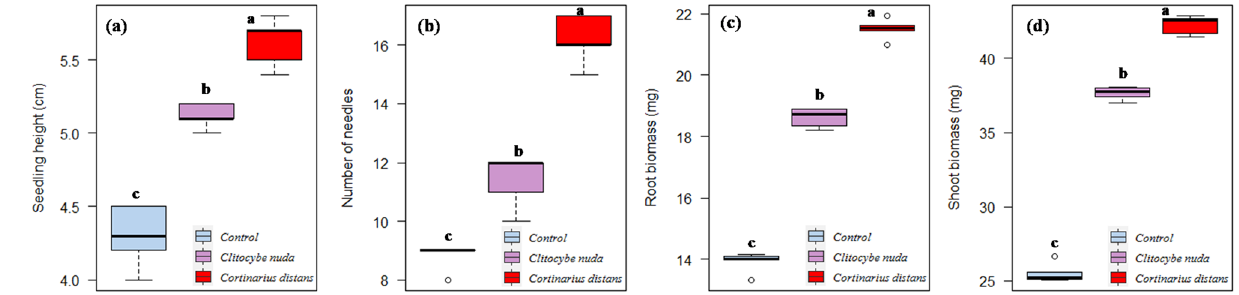
Figure 5. Boxplots showing effect of ECM inoculation on seedling growth traits ( a ) seedling height, ( b ) Number of needles, ( c ) root biomass, and ( d ) shoot biomass of Picea smithiana